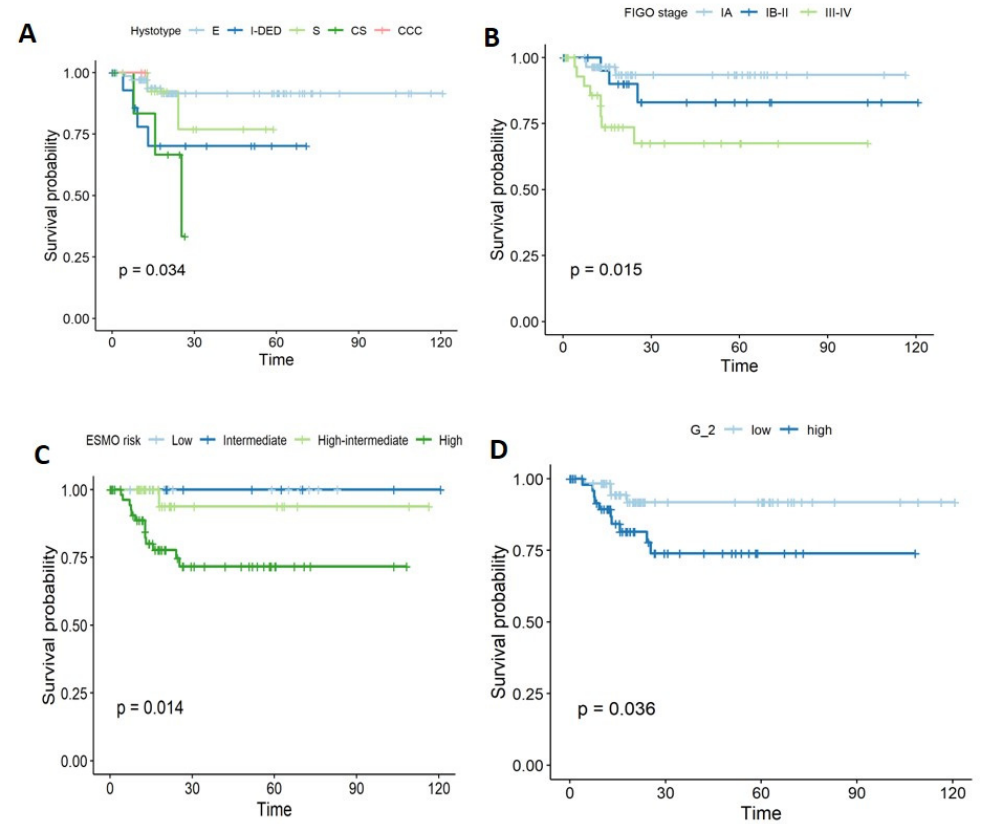
Figure 1. Kaplan–Meier curves showing the parameters associated with recurrence and ( A ) hystotype, ( B ) FIGO Stage, ( C ) ESMO risk, and ( D ) grade. None of the other analyzed parameters were significantly associated with recurrence.